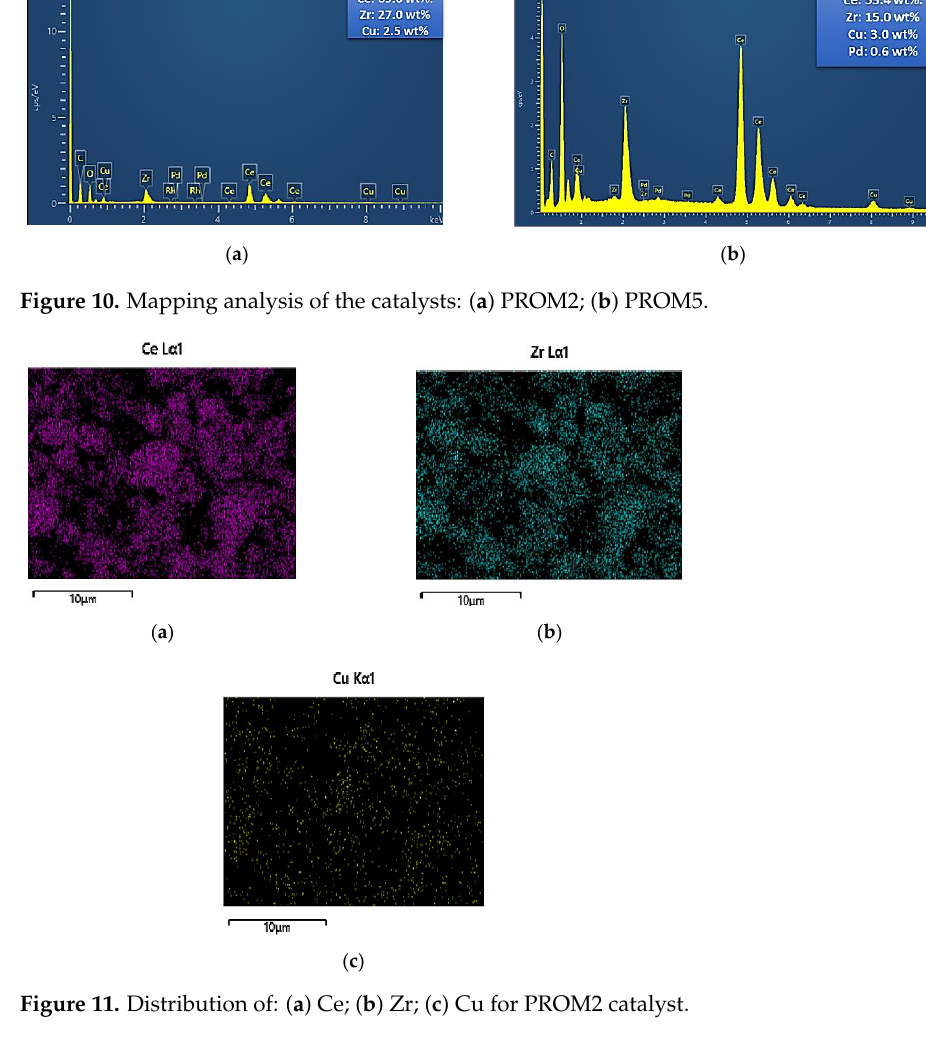
Figure 9. Scanning electron microscope (SEM) images of catalyst PROM2 ( a ) × 5000; ( b ) × 7000 and catalyst PROM5 ( c ) × 1000; ( d ) × 3000.